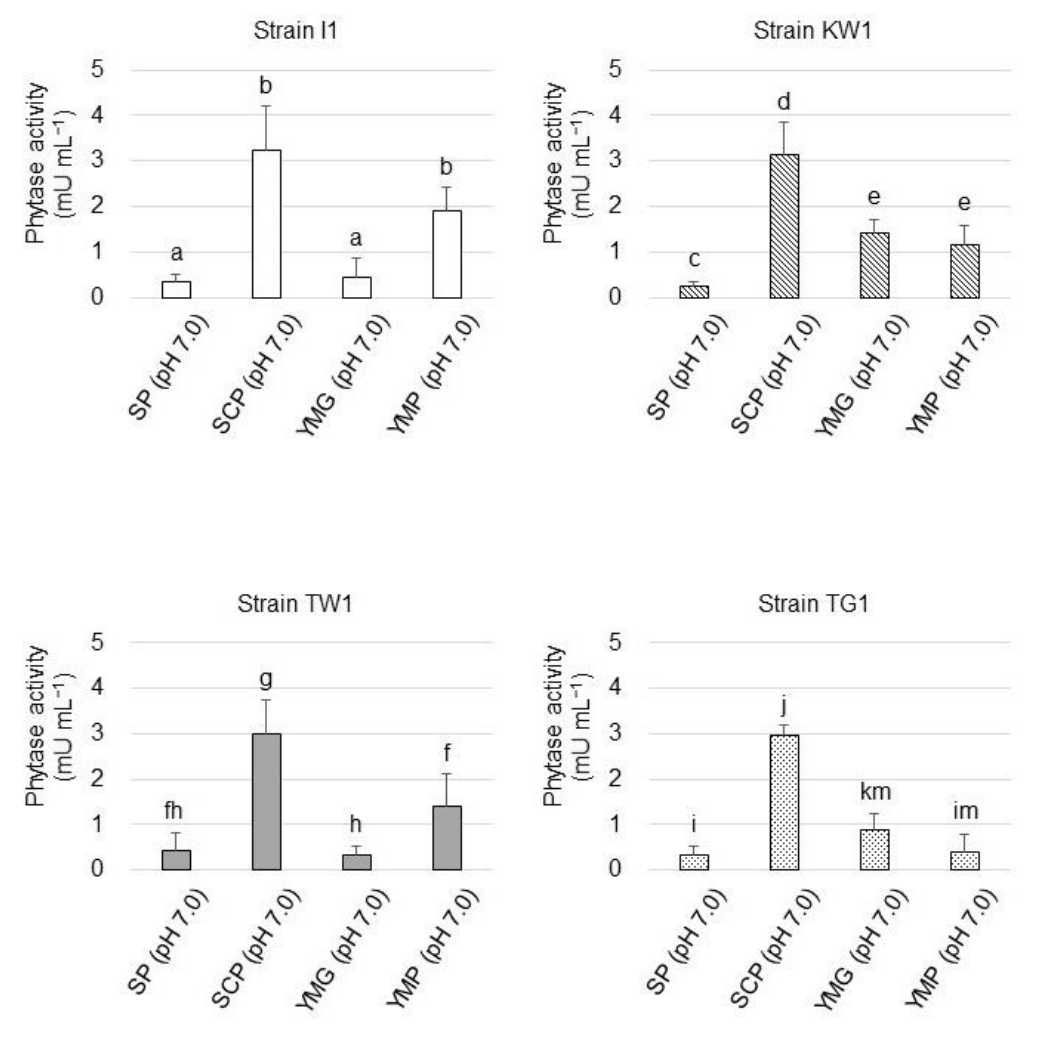
Figure 6. Phytase yield of the isolated strains grown at different nutritive levels based on the enzyme activity in their culture supernatants. The data are presented as means ± standard deviation of independent triplicates. Columns with different letters (a–k and m) indicate significant difference at p < 0.05 (Student’s t -test).